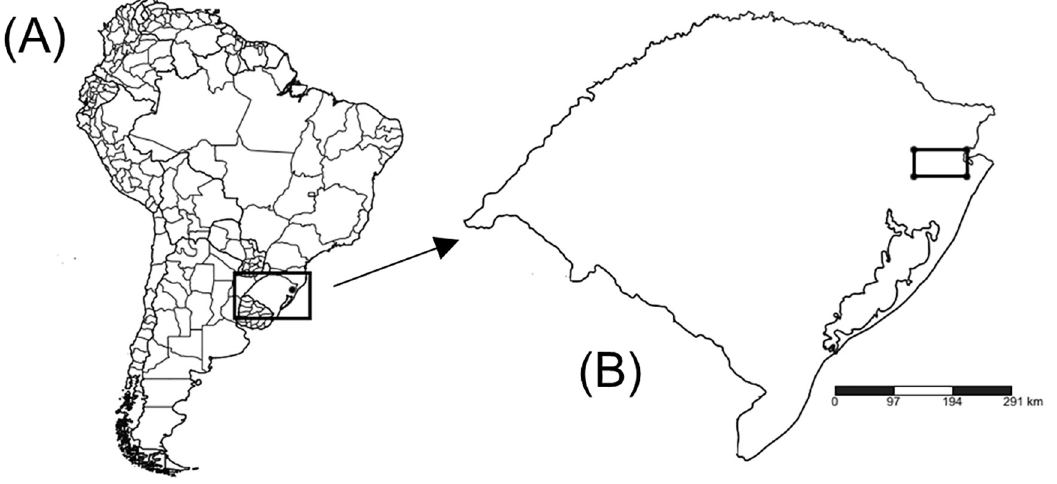
Fig 3. Case study region. (A) Geographical region of study area (South America with the state of Rio Grande do Sul, Brazil in rectangle). (B) Rio Grande do Sul, Brazil with case study region in rectangle.